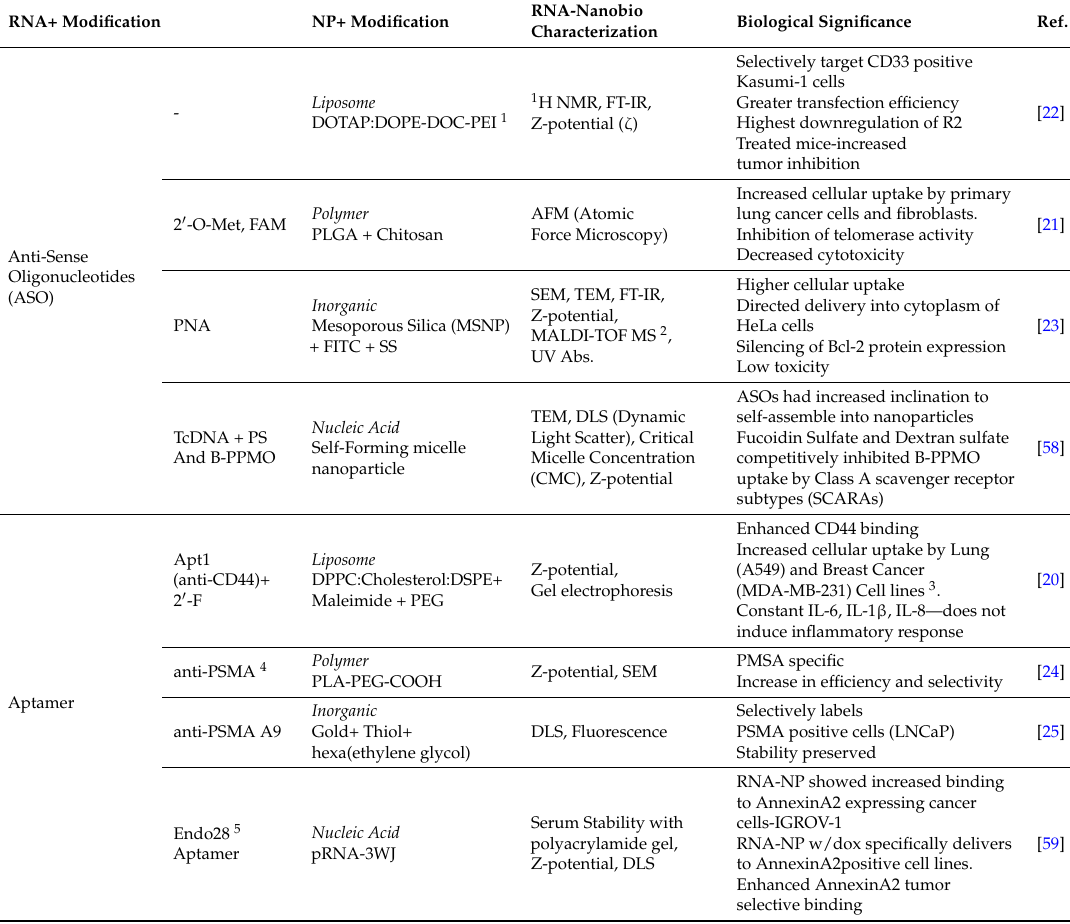
Biological Significance